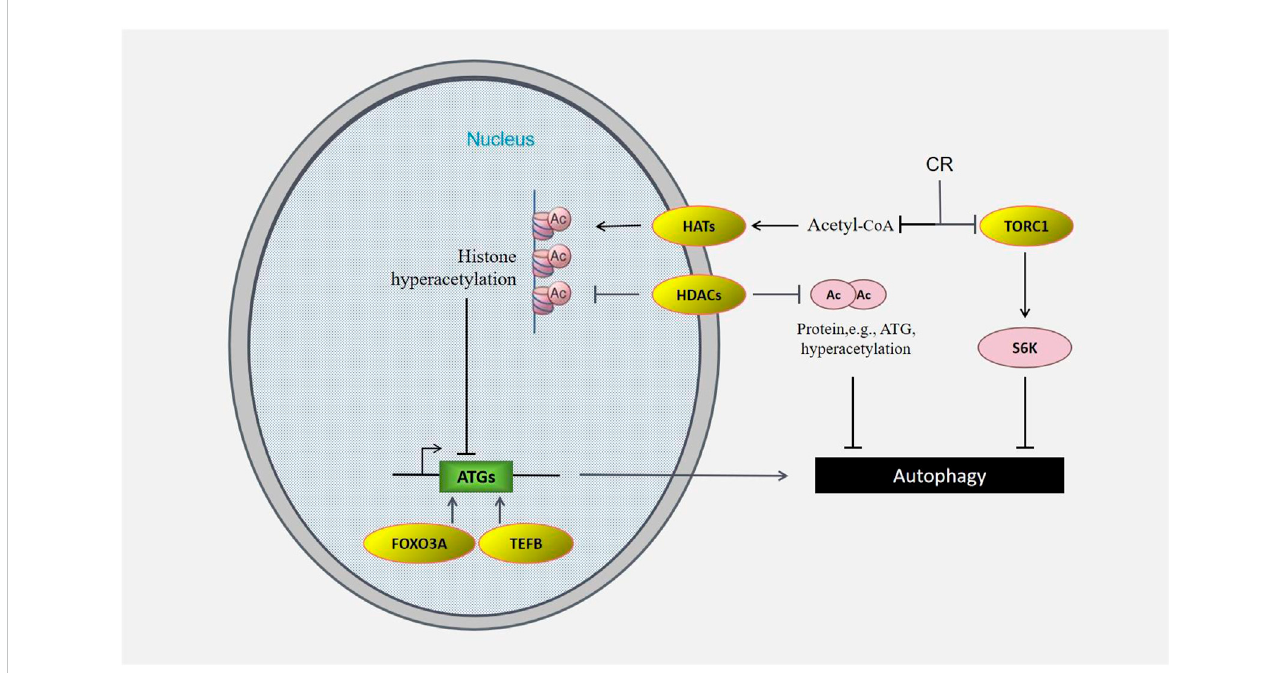
FIGURE 4 CRregulatesepigenetic versus autophagicinduction.AciscontrolledbylevelsofHATssuchasEP300,HDACssuchasSIRT1,andacetyl-CoA.Inaddition toepigeneticregulation via histone acetylation andmethylation, transcriptionfactorssuchas FOXO3a orTFEB alsoin fl uencetranscriptionofpro-autophagic genes such as